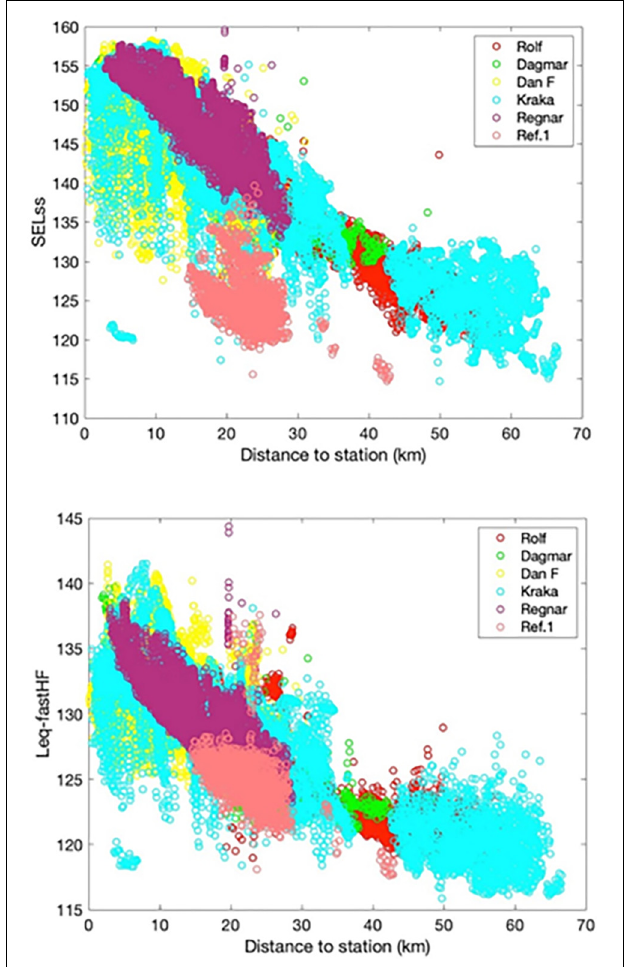
FIGURE 4 | Measured noise level for single pulse SEL SS , and L eq − fastHF with distance to source vessel. Different colors indicate the different recording stations shown in the legend. Each pulse is thus included up to six times at different ranges.